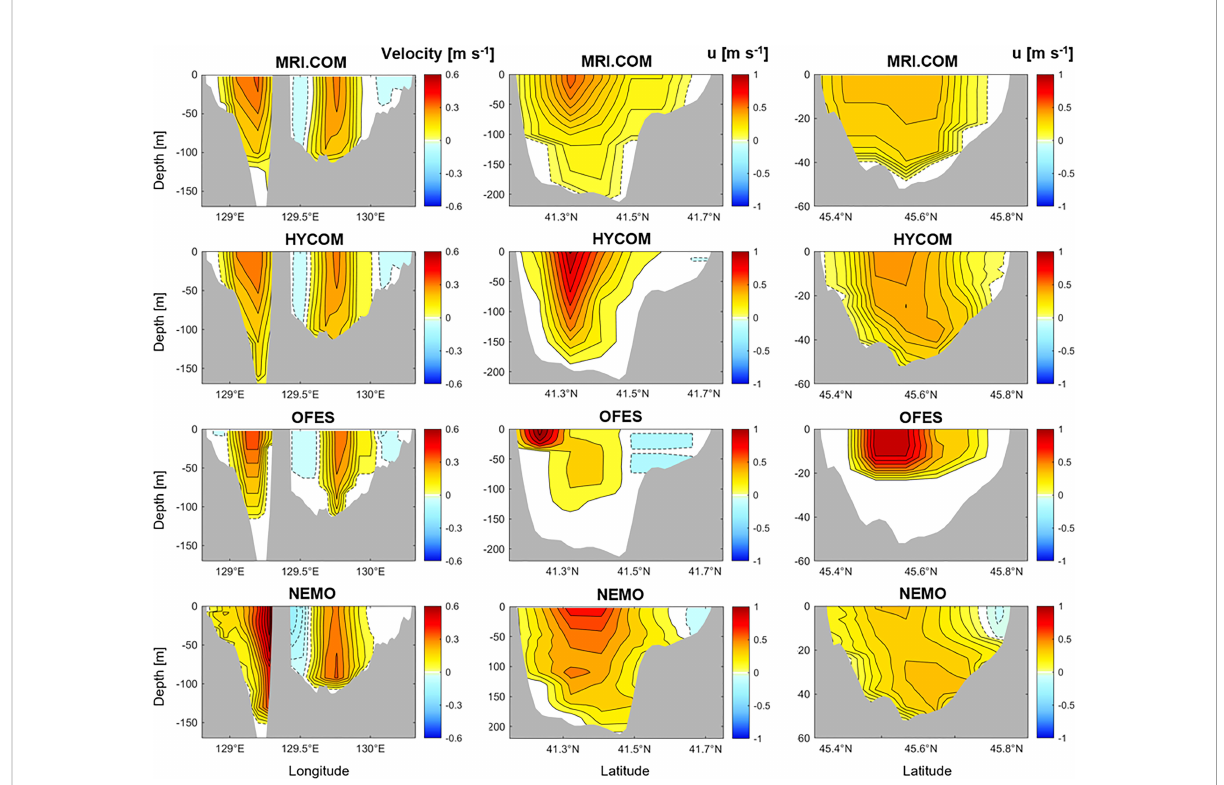
FIGURE 9 Mean current velocity pro fi les across the Tsushima Strait (left), Tsugaru Strait (middle), and Soya Strait (right) for the time period from 1993 to 2014 for the models MRI.COM, HYCOM, OFES, and NEMO. Positive values denote northeastward velocity for Tsugaru Strait and eastward velocity for Tsugaru Strait and Soya Strait. Isolines are solid for positive values and dashed for negative values. Note that the shown pro fi les cover different ranges of depth. The contour interval is 0.1 m/s for each